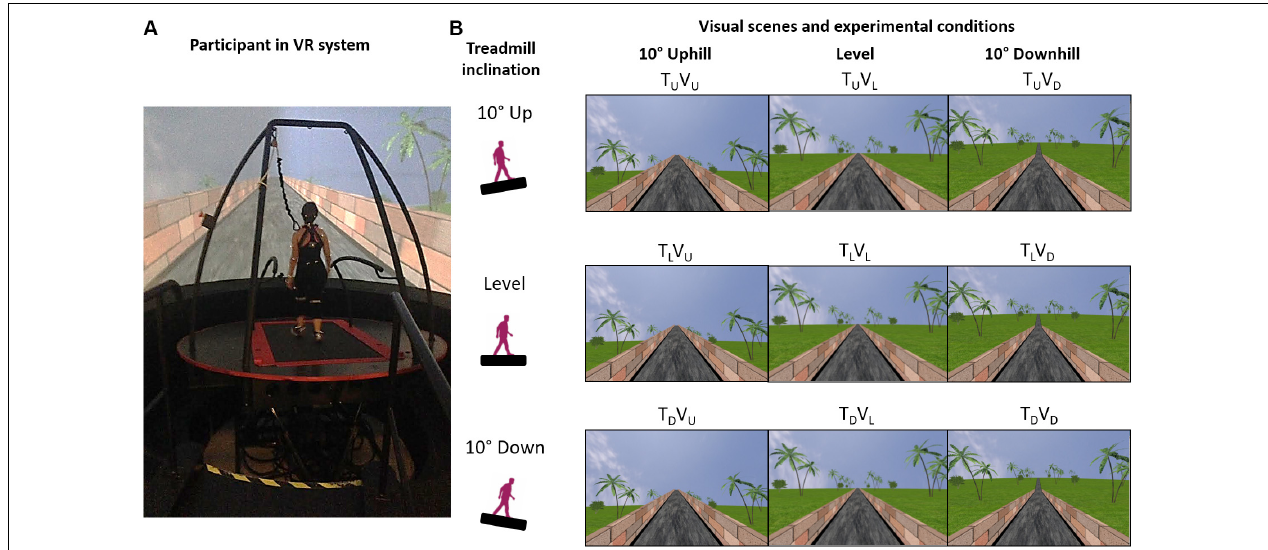
FIGURE 1 | Apparatus and experimental conditions. (A) A fully immersive virtual reality (VR) system containing an embedded treadmill synchronized with visual scenes projecting a moving road on a large 360 ◦ dome-shaped screen in a room-sized VR facility. (B) During level walking, participants experienced nine different conditions presented in random order, in which the inclination of the treadmill (T) and/or visual scenes (V) transitioned to 10 ◦ uphill (U), remained level at 0 ◦ (L) or transitioned to -10 ◦ downhill (D). Conditions are illustrated as a 3 × 3 matrix, in which rows represent the inclination of the treadmill (T) and columns represent the inclination of the visual scene (V). Congruent condition T L V L represents continued level walking, and T U V U and T D V D represent congruent uphill and downhill walking, respectively. The other conditions are incongruent: only vision up (T L V U ) or down (T L V D ), only treadmill up (T U V L ) or down (T D V L ), treadmill down-vision up (T D V U ), and treadmill up-vision down (T U V D